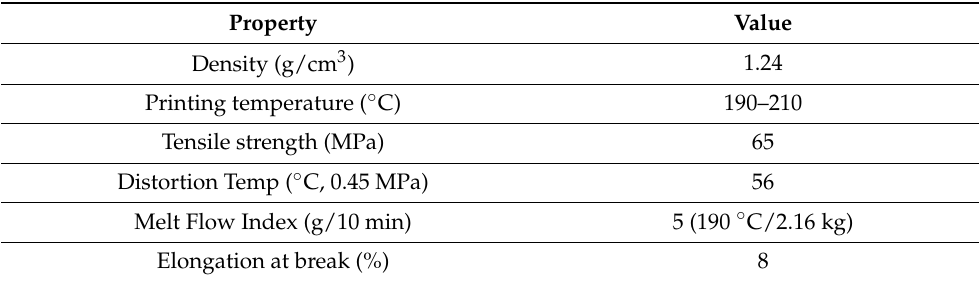
Figure 1. Test sample model: ( a ) Geometrical details and building orientation of the sample on the FDM building platform; ( b ) one direction linear infill hatching pattern. FDM building platform; ( b ) one direction linear infill hatching pattern. Table 2. PLA’s properties (supplier’s data). Table 2. PLA’s properties (supplier’s